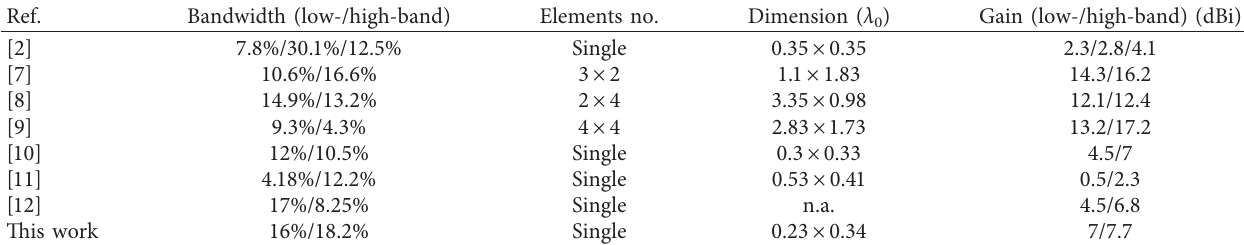
Table 2: Comparison to reported dual-band or multifrequency antenna and arrays.